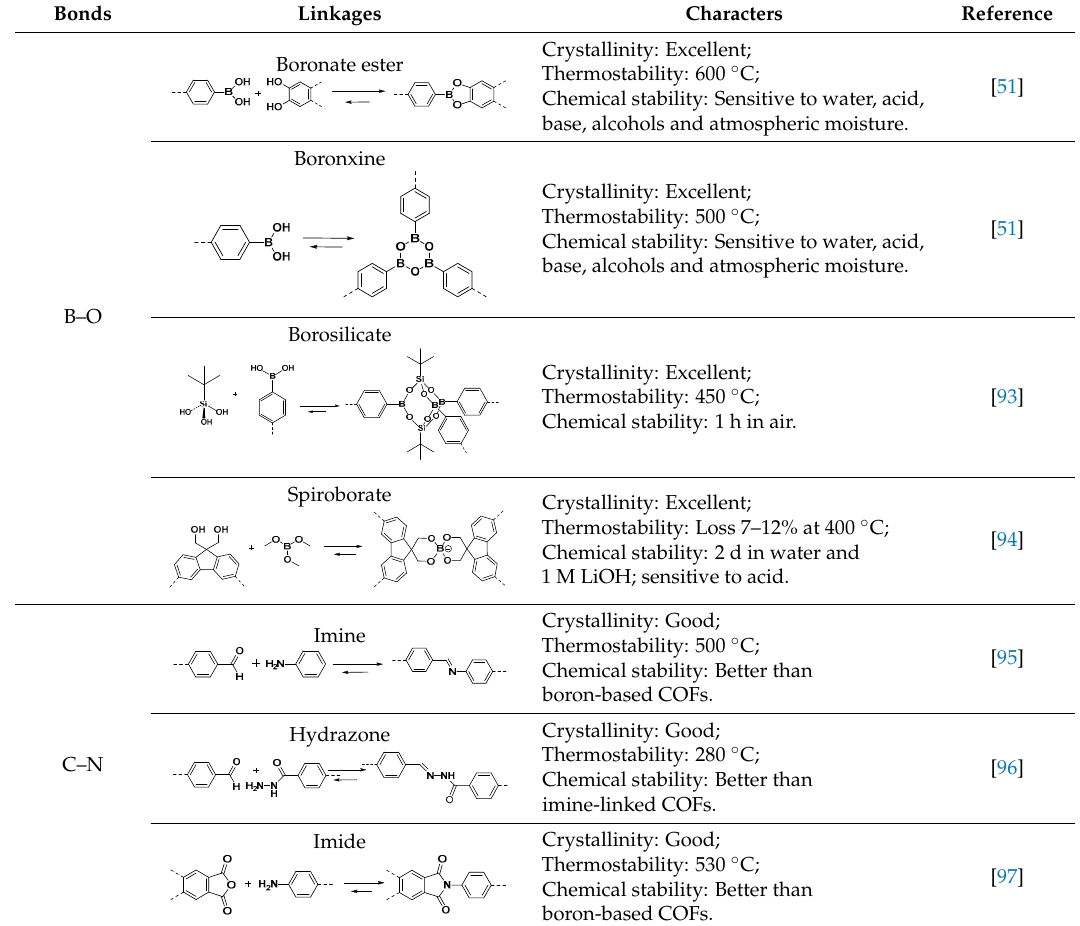
Table 2. Typical linkages for building COFs.